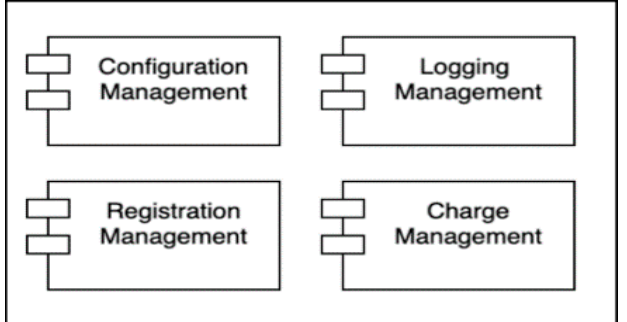
Figure 5. The EVO mobile app modules.